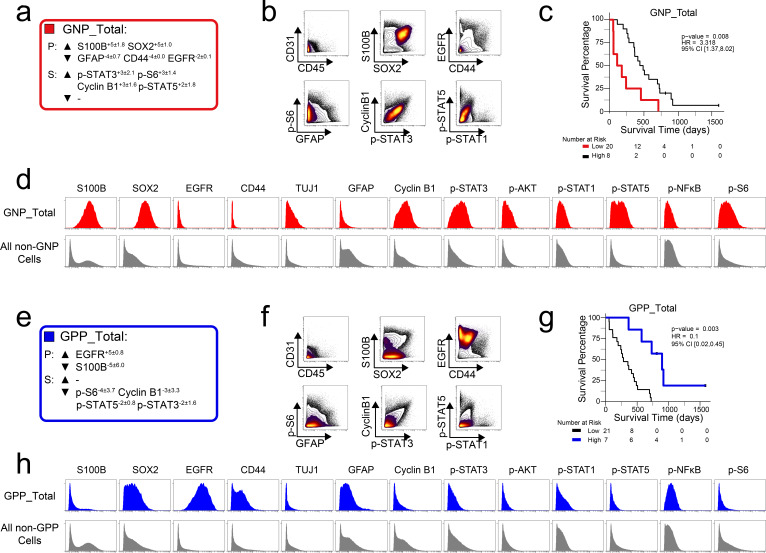
Divergent phenotypes are associated with patient outcomes.(a) Enrichment (upwards arrowhead) or lack (downwards arrowhead) of identity proteins (P) and phosphorylated signaling effectors (S) on Glioblastoma Negative Prognostic cell subsets was quantified using MEM. Average MEM scores are shown for three GNP subsets ± the standard deviation. (b) Combined GNP cell subsets (density contours) were mapped over biaxial plots of all other tumor cells (black contours). (c) Overall survival of patients for high (>2.96%) total GNP content compared to patients with low (<2.96%) GNP content. (d) Histogram plots of GNP cells (red) and all other glioblastoma cells (gray) illustrate the expression of identity proteins and phosphorylated signaling effectors. (e) Enrichment (upwards arrowhead) or lack (downwards arrowhead) of identity proteins (P) and phosphorylated signaling effectors (S) on Glioblastoma Positive Prognostic cell subsets was quantified using MEM. Average MEM scores are shown for three GNP subsets ± the standard deviation. (f) Combined GPP cell subsets (density contours) were mapped over biaxial plots of all other tumor cells (black contours). (g) Overall survival of patients for high (>8.65%) total GPP content compared to patients with low (<8.65%) GPP content. (h) Histogram plots of each GPP cell subset (blue) and all other glioblastoma cells (gray) illustrate the expression of proteins and phosphorylated signaling effectors.